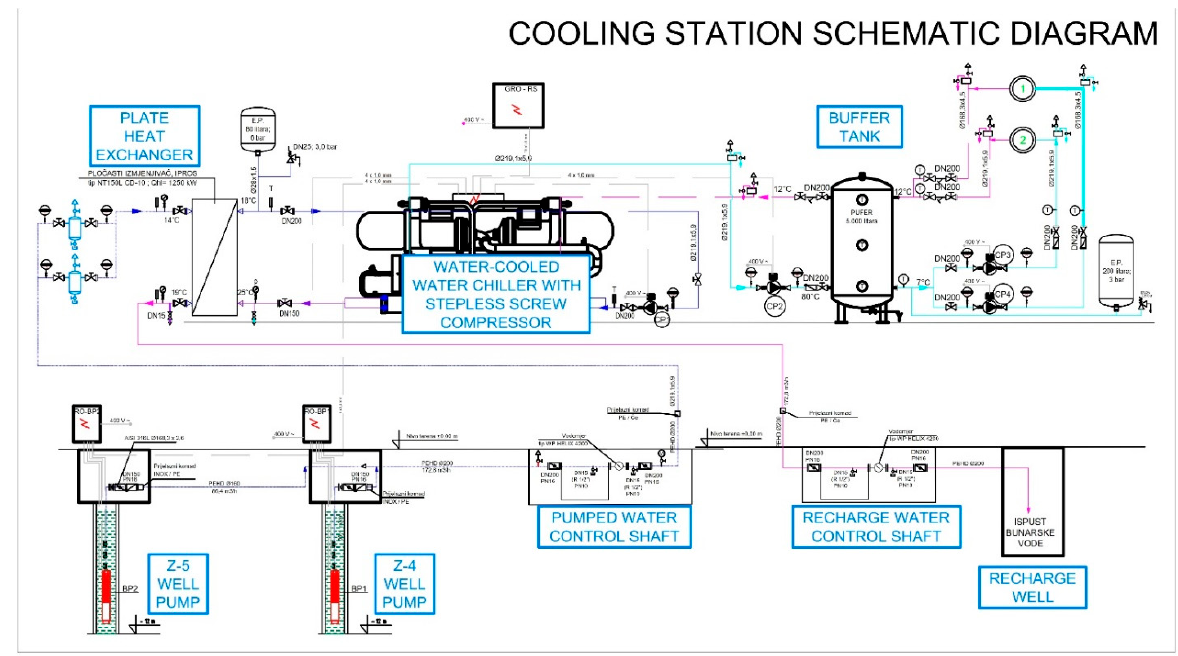
Figure 10. Cooling station schematic diagram for discharging wells Z-4 and Z-5.